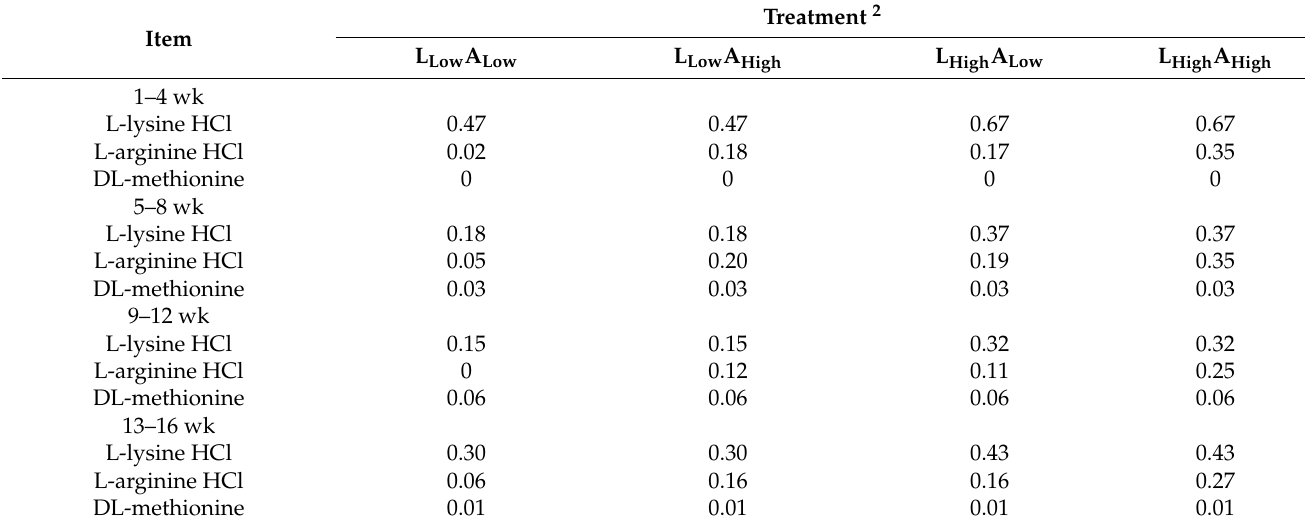
Table 2. Amounts of supplemental synthetic amino acids added to the basal diet, g/100 g 1